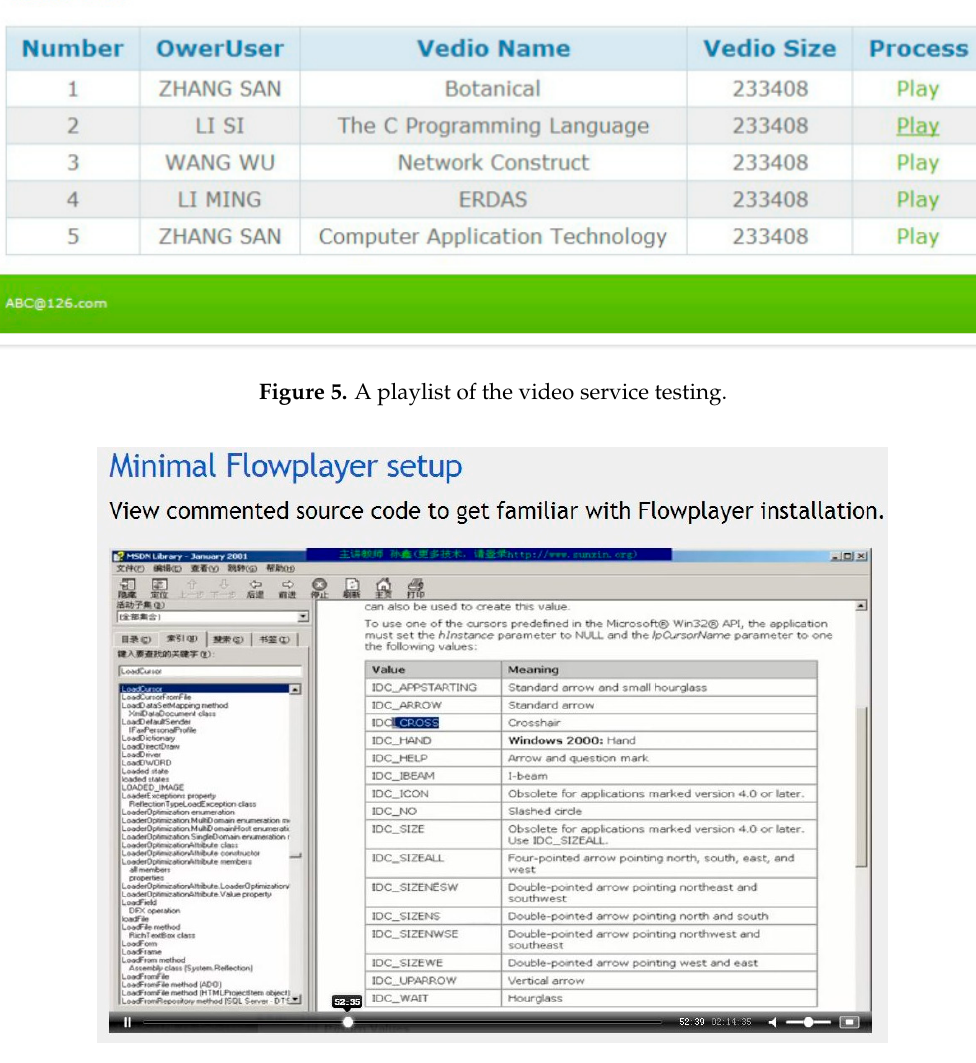
Figure 6. The video screenshot at time 00:52:35.